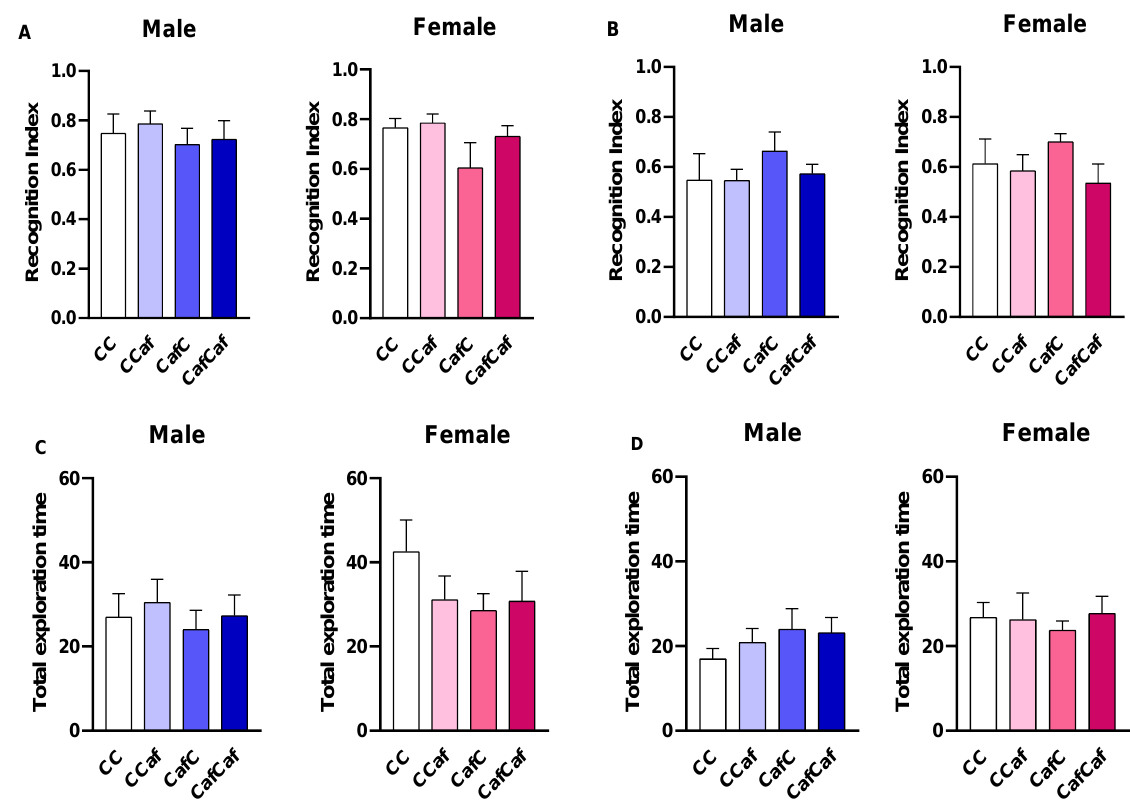
Figure 8. Elevated plus maze test results in male ( A ) and female ( B ) offspring. ChowChow (11 male, 11 female), ChowCaf (11 male, 11 female), CafChow (13 male, 11 female), and CafCaf (13 male, 13 female); C depicts chow. The percentage of time spent in open and closed arms, and in the middle square were determined for each animal over a 5 min session. Data are expressed as mean ± SEM and were analysed by three-way ANOVA. * p < 0.05 significant effect of maternal Caf diet. Place/object test Behaviour Our results showed no significant effect of maternal or offspring diet on object or place recognition tasks, nor in total exploration time (Figure 9).